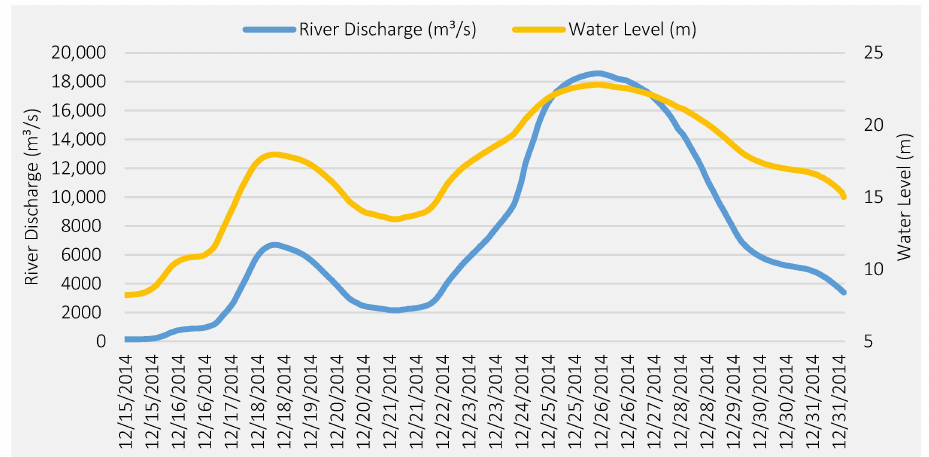
Figure 5. Input (Discharge) data for inlet boundary conditions–upstream and input (Water Level) data for outlet boundary